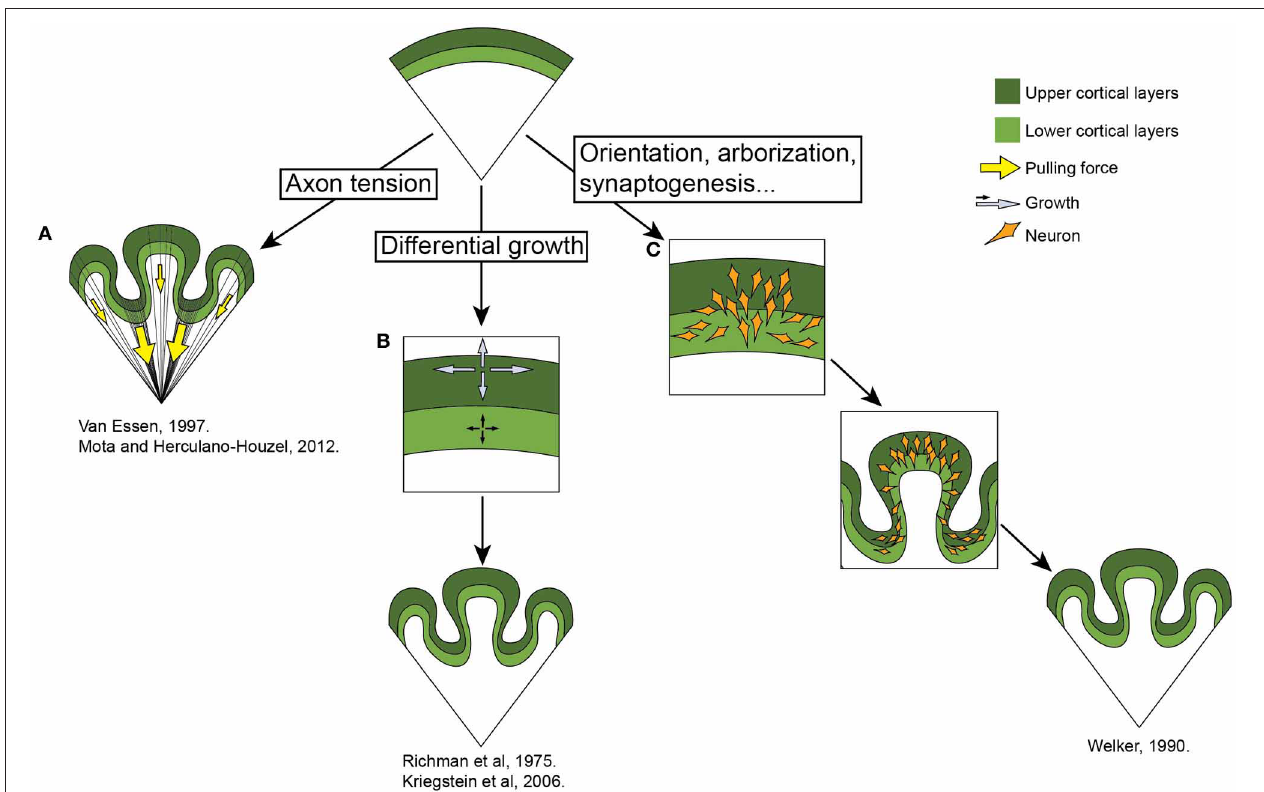
FIGURE 2 | Theories of gyrogenesis. (A) Neuronal tension (Van Essen, 1997; Mota and Herculano-Houzel, 2012). This theory stresses the differential pulling forces of the underlying white matter on the neocortex, resulting in the convoluted appearance of the brain. (B) Differential growth (Richman et al., 1975; Kriegstein et al., 2006)